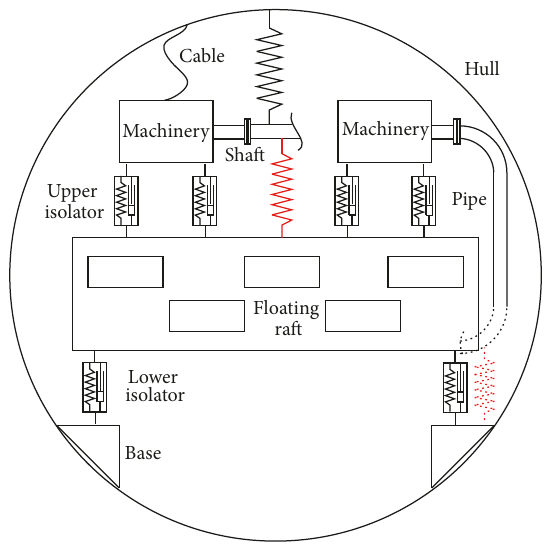
Figure 1: Sketch of the floating raft system with attached